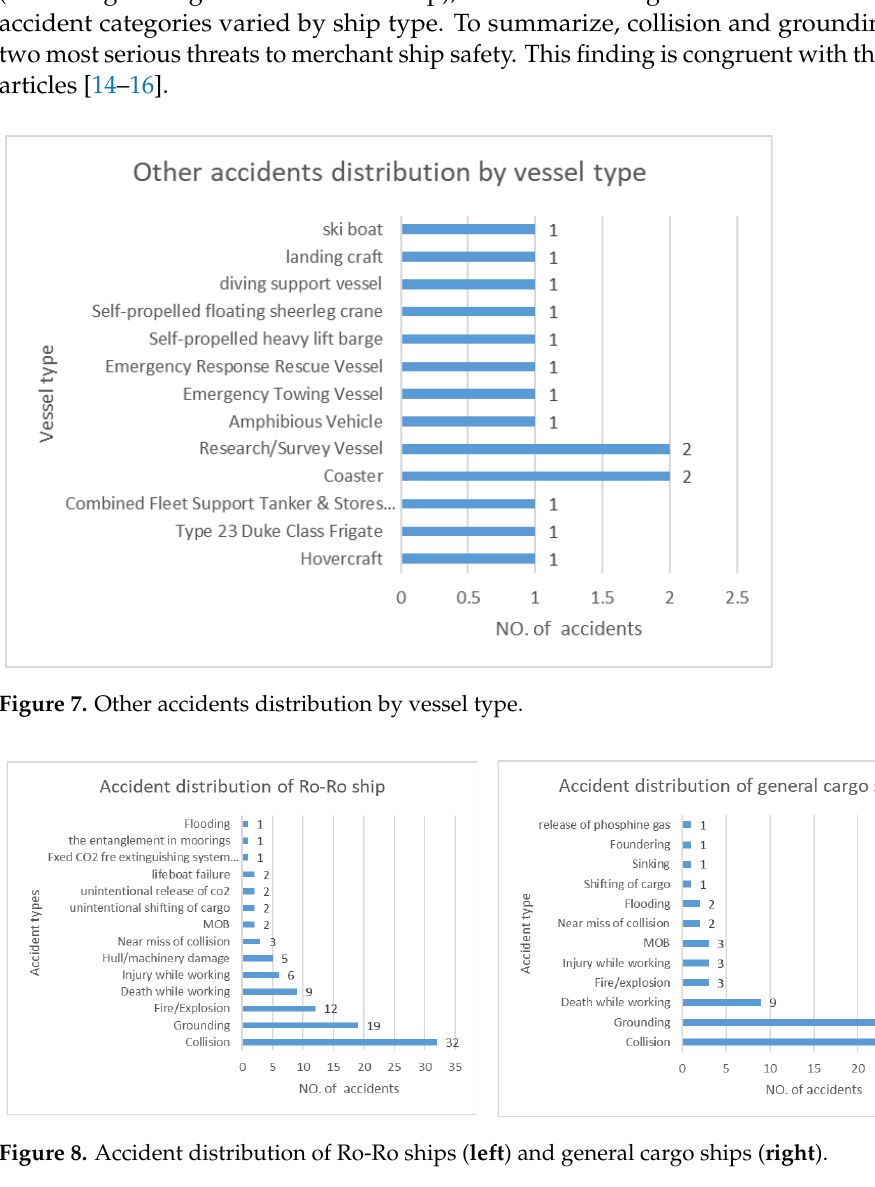
Figure 8. Accident distribution of Ro-Ro ships ( left ) and general cargo ships ( right ).